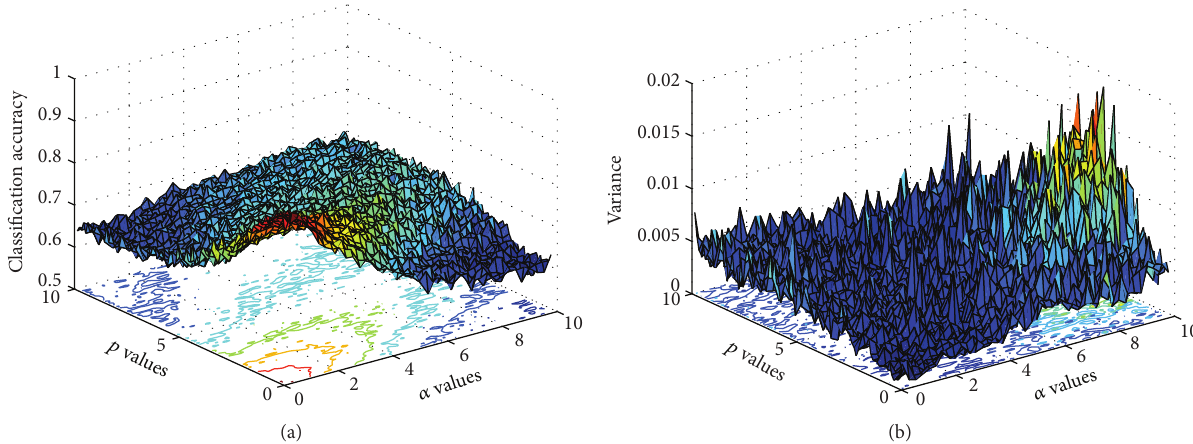
Figure 3: Mean classification accuracies (a)and the variances (b)obtained fromthe echocardiogram data set with thetrigonometric linguistic quantifier variant of the Bonferroni-OWA based similarity